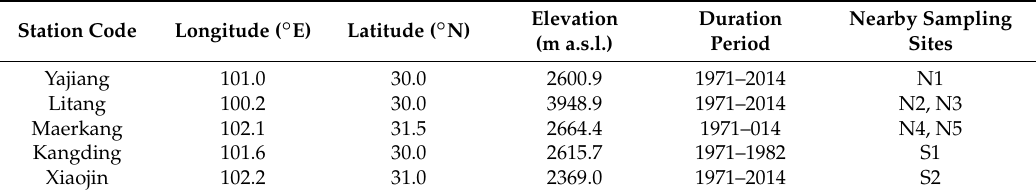
Table A1. Characteristics of regional meteorological stations located near the seven sampling